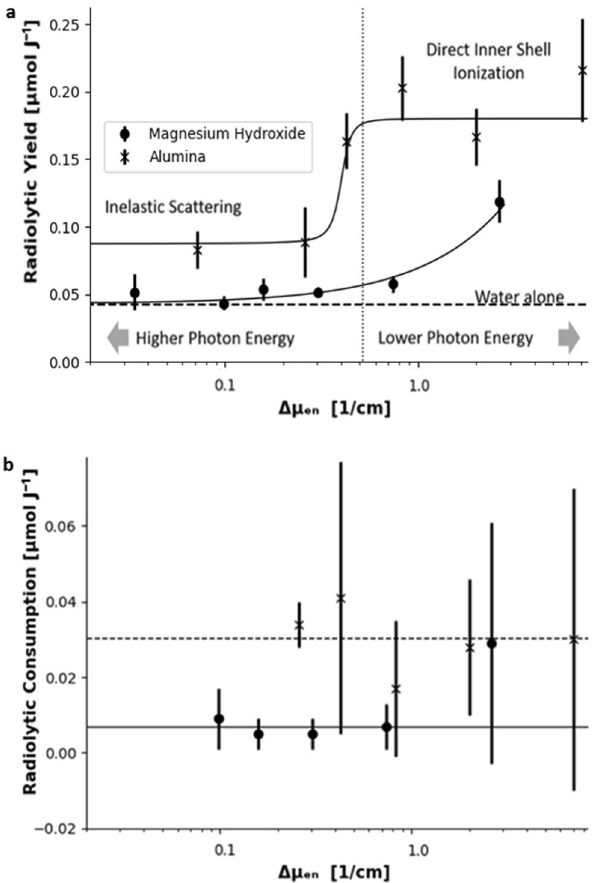
Figure 4. Panel ( a ) shows the measured radiolytic hydrogen yields plotted against the difference between energy absorption coefficients of the particulate phase and the aqueous phase. The highest photon energy results on this plot are measurements of radiolytic hydrogen yields from Co-60 irradiation of both magnesium hydroxide sludge and alumina sludge. The alumina measurement is taken from the literature 18 . The cross marks in the plot show the alumina sludge results and the magnesium hydroxide sludge results are plotted as solid circles. The horizontal axis is plotted on a logarithmic scale. The dashed line indicates the radiolytic yield for water alone. The vertical dotted line indicates the value at which inelastic scattering (Compton scattering) and direct ionization (photoelectric effect) cross-sections are equal in alumina; to the left of this line most ionization events are from inelastic scattering of the most loosely bound electrons; to the right of this line most ionization events are from direct photon absorption, which eject the most tightly bound electrons. The black curves indicate the trend in the data, which is an arbitrary step function for alumina and a linear fit for magnesium hydroxide. Panel ( b ) shows a plot of the measured radiolytic hydrogen consumption against the same variable but does not include the results from Co-60 irradiations. The radiolytic consumption shows no detectable trend. The dashed line plots the trend of radiolytic consumption for alumina and the solid line for trend of radiolytic consumption for magnesium hydroxide. Figure made with plots plotted with matplotlib 55